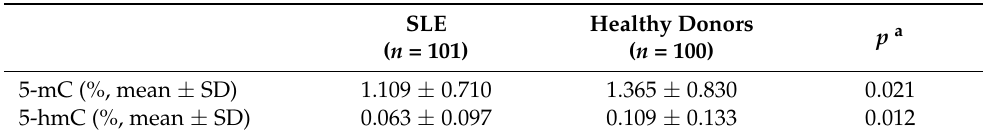
Table 2. Global methylation and hydroxymethylation in the PBMCs of systemic lupus erythematosus patients and healthy